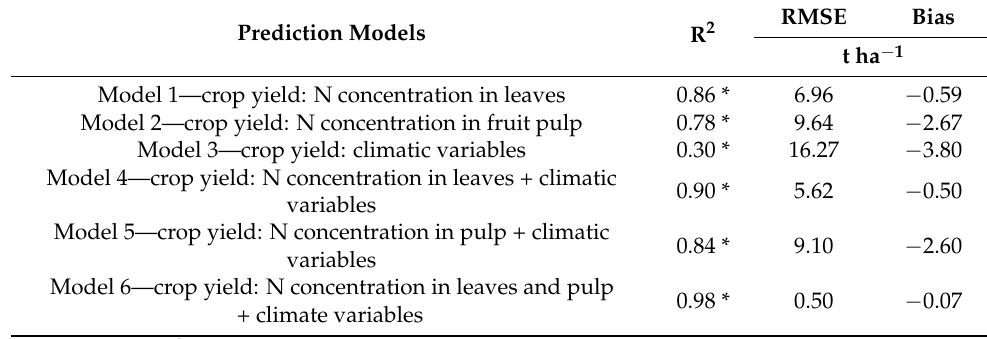
Table 1. Accuracy of apple-yield prediction models for ‘Fuji Suprema’ and ‘Royal Gala’ in two locations and for four crop seasons.